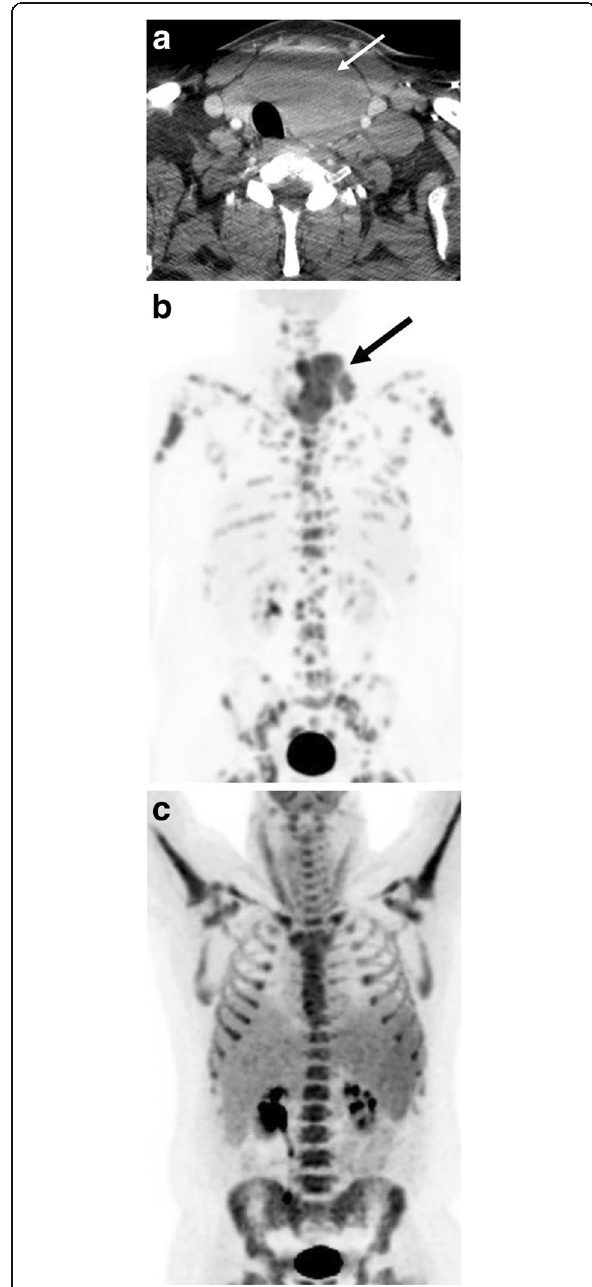
Fig. 14 Treatment response. A 42-year-old man initially presenting with neck mass and constitutional symptoms. Contrast-enhanced axial CT at presentation ( a ) demonstrates a large left neck mass (arrow) replacing the left thyroid with tracheal deviation. b Staging whole body planar PET image demonstrates a hypermetabolic left lower neck mass (arrow) and heterogeneous marrow involvement. The patient underwent R-CHOP with intrathecal methotrexate, 4 cycles of hyper-CVAD and intrathecal methotrexate. Follow-up ( c ) whole-body planar PET image imaging show resolution of the cervical mass without evidence of distant disease. Diffuse homogeneous marrow uptake on the PET scan is likely related to post-therapy marrow